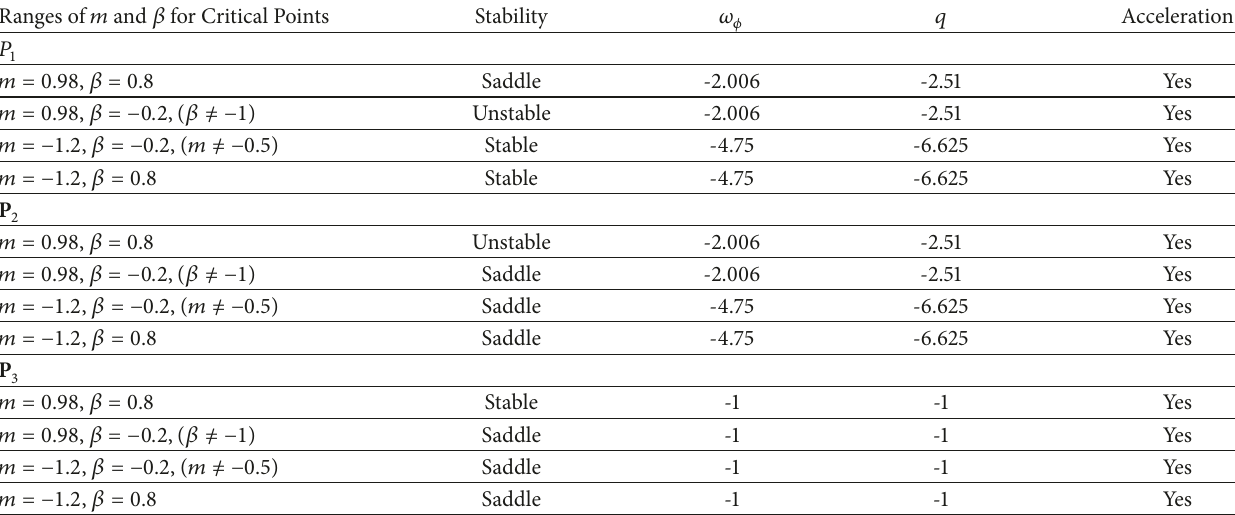
Table 4: Phase Space Analysis of Tachyon Coupled System with 𝑄 = 𝛽 ̇𝜎 𝜙